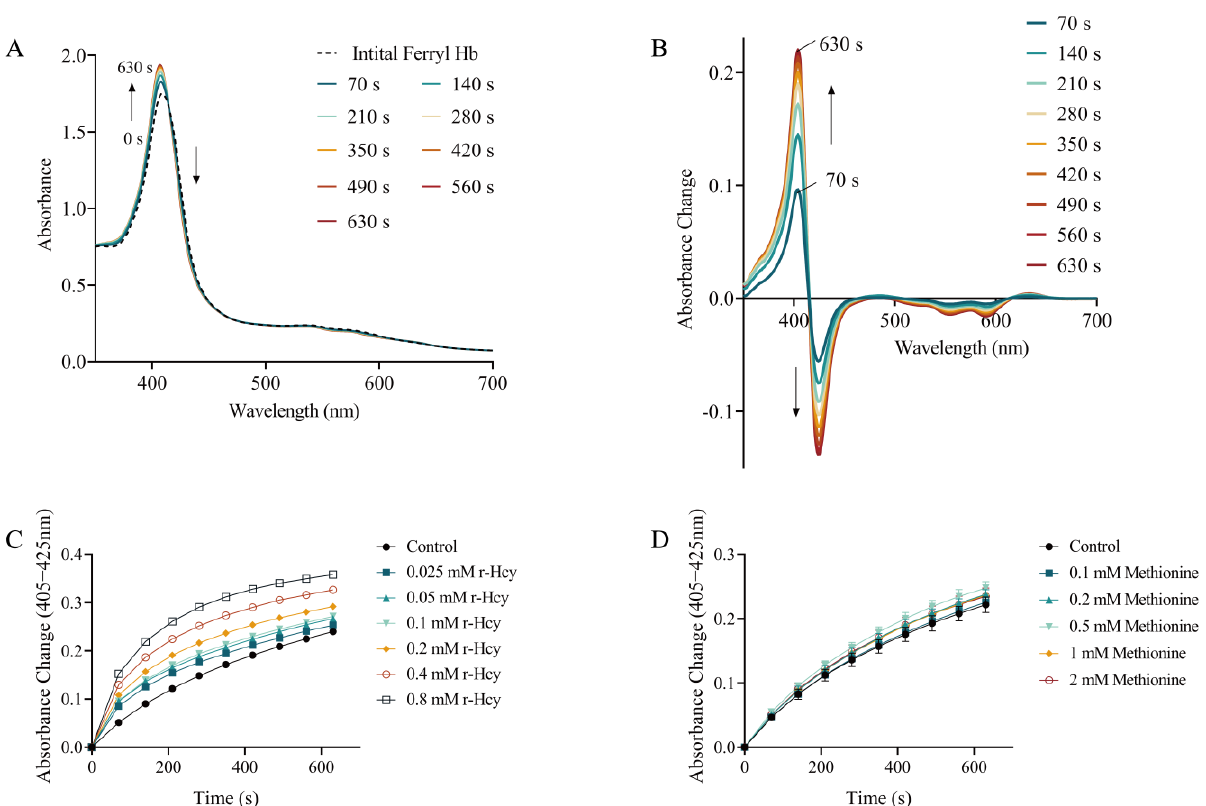
Figure 4. The effects of r-Hcy and methionine on ferryl Hb decay. ( A ) Representative absorbance spectra taken every 70 s after the addition of 0.8 mM r-Hcy (different color line represented different time point). ( B ) Absorbance change curves derived from original absorbance spectra in which initial ferryl Hb (Fe 4+ ) spectra were set to zero. Time courses of ferryl (Fe 4+ ) reduction at different concentrations of r-Hcy ( C ) or methionine ( D ). Addition of 0.025~0.8 mM r-Hcy to ferryl Hb (Fe 4+ ) solution led to conversion of ferryl Hb (Fe 4+ ) to ferric Hb (Fe 3+ ) in concentration-dependent and time-dependent manners. However, the addition of 0.1~2 mM methionine to ferryl Hb (Fe 4+ ) solution did not significantly change the heme state, compared with control ( p > 0.05), except that 0.5 mM methionine caused a slight but significantly increased conversion of ferryl Hb (Fe 4+ ) to ferric Hb (Fe 3+ ). The detailed data can be found in Supplementary Tables S4 and S5.